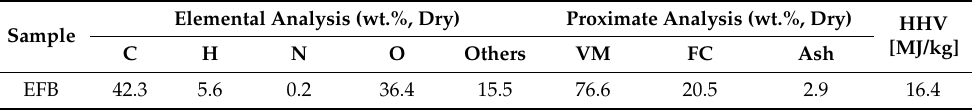
Table 1. Characteristics of dry empty fruit bunches (EFB) used in this study.